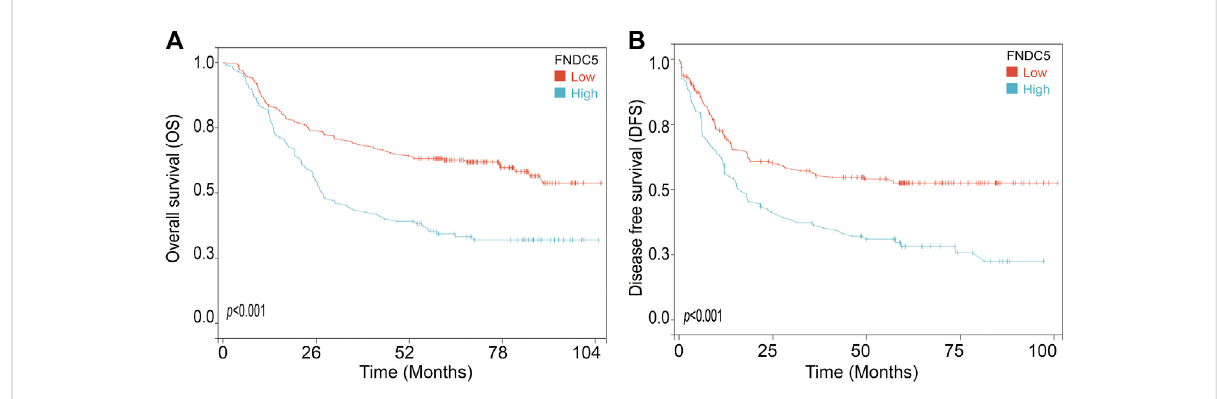
FIGURE 2 The effect of FNDC5 on the prognosis for gastric cancer patients. The (A) OS and (B) DFS analysis for FNDC5 in gastric cancer patients in